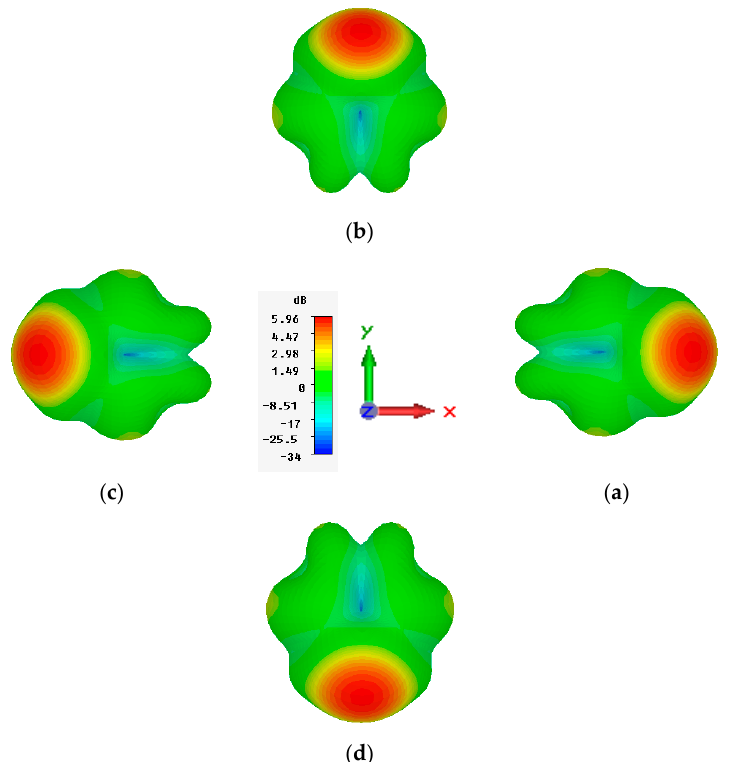
Figure 9. Simulated 3D radiation patterns at 5.8 GHz: ( a ) State 1, ( b ) State 2, ( c ) State 3, ( d ) State 4.